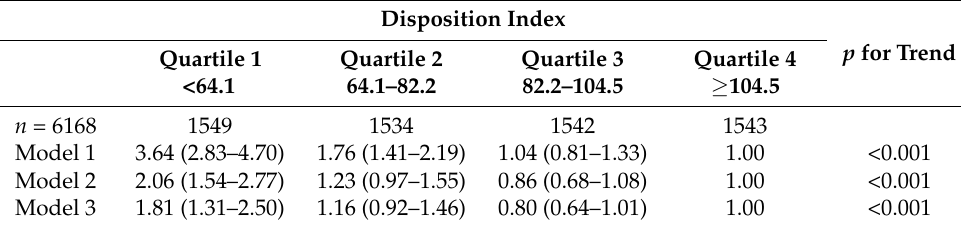
Table 4. Adjusted odds ratios (95% confidence intervals) of NAFLD according to disposition index quartiles using logistic regression.